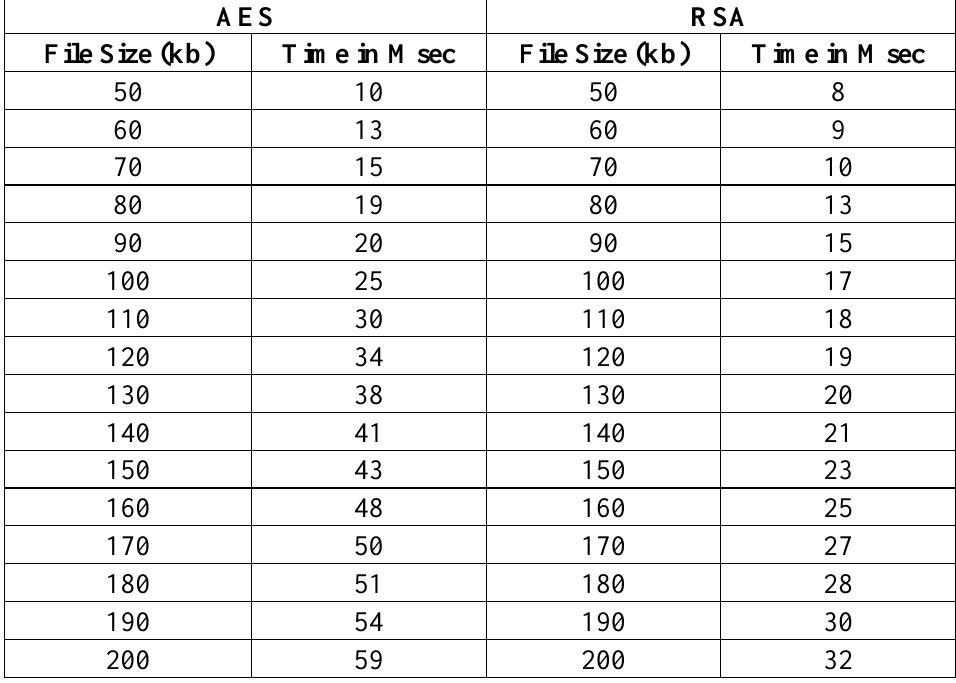
Table 4. File Uploading Time of AES and